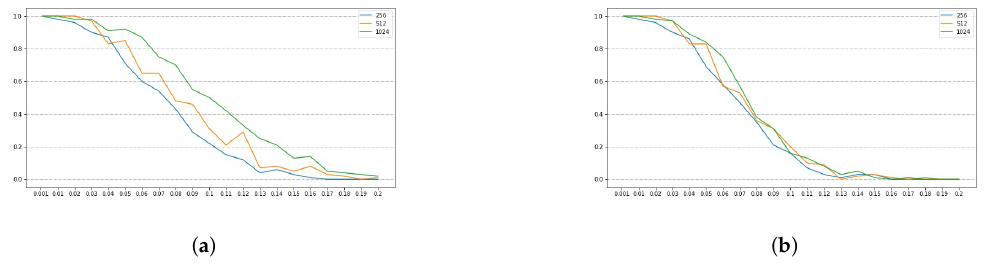
Figure 2. Success rates for the SIKE parameters SIKEp434 for α = 0.001. The y -axis denotes the success rate, while the x -axis denotes β 0.001,0.01,0.02, . . . ,0.2 . ( a ) Comparing success rates for M j 256,512,1024 in a full enumeration. ( b ) Comparing success rates for M j 256,512,1024 in a 2 40 enumeration.